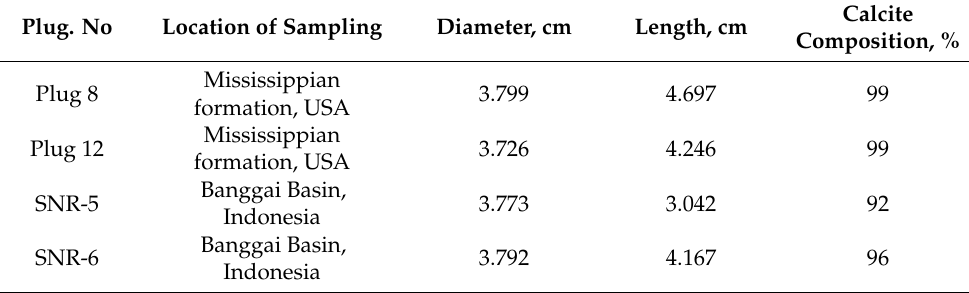
Table 2. Characteristics of limestone core